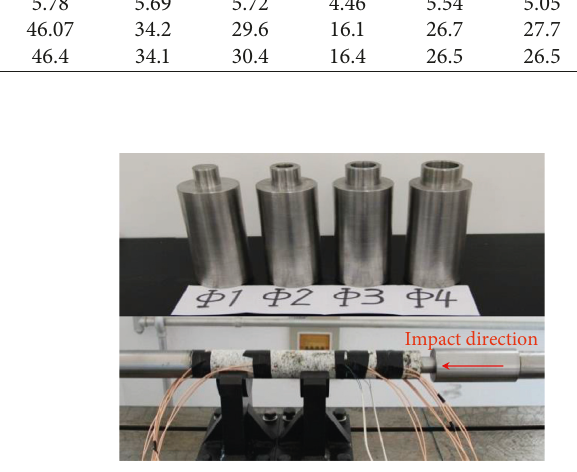
Figure 9: Modified ends of the incident bar. Table 2: Specifications of the modified ends in SHPB tests.